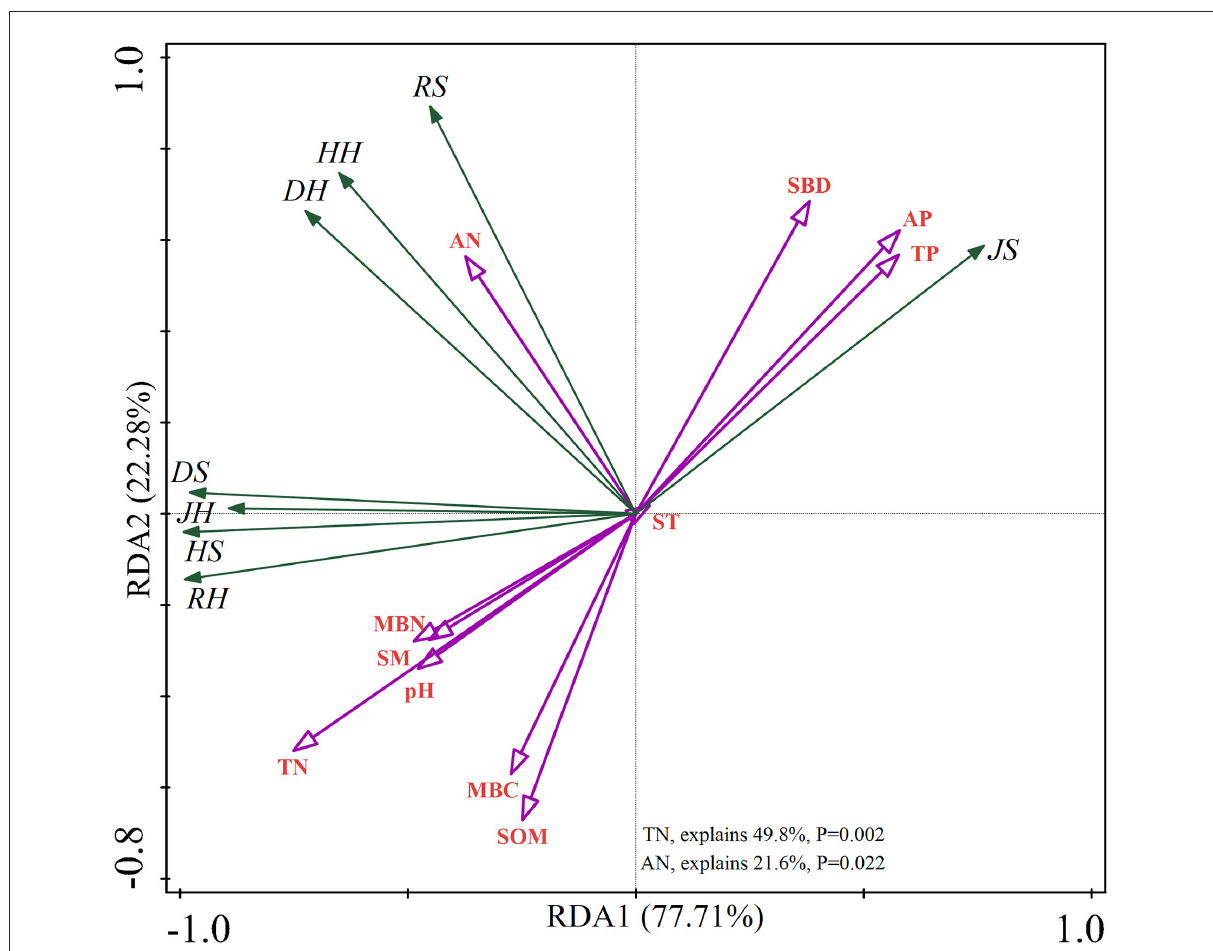
FIGURE1 Redundancy analysis (RDA) of understory plant diversity with soil properties. “S” stands for small gaps; “M” stands for medium gaps; and “L” stands for large gaps.